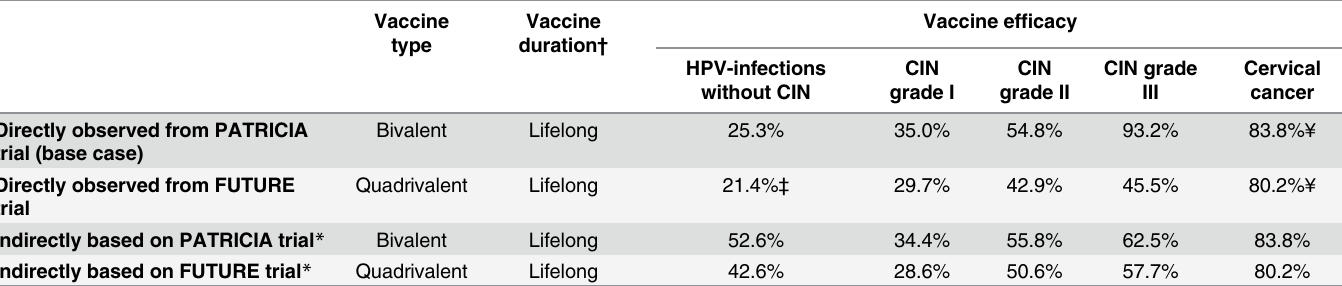
Table 1. Vaccination assumptions for base case analysis and sensitivity